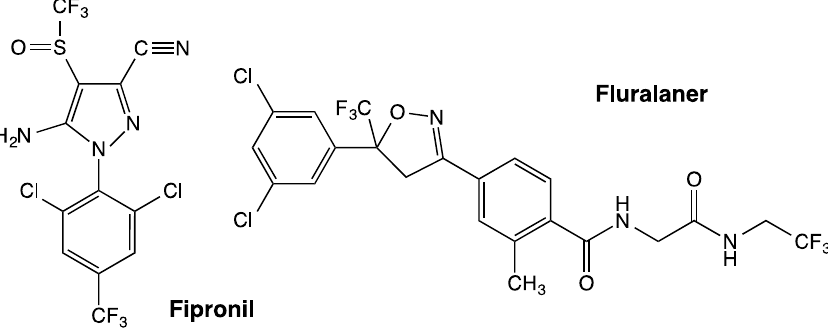
Figure 1. Chemical structures of fipronil and fluralaner.